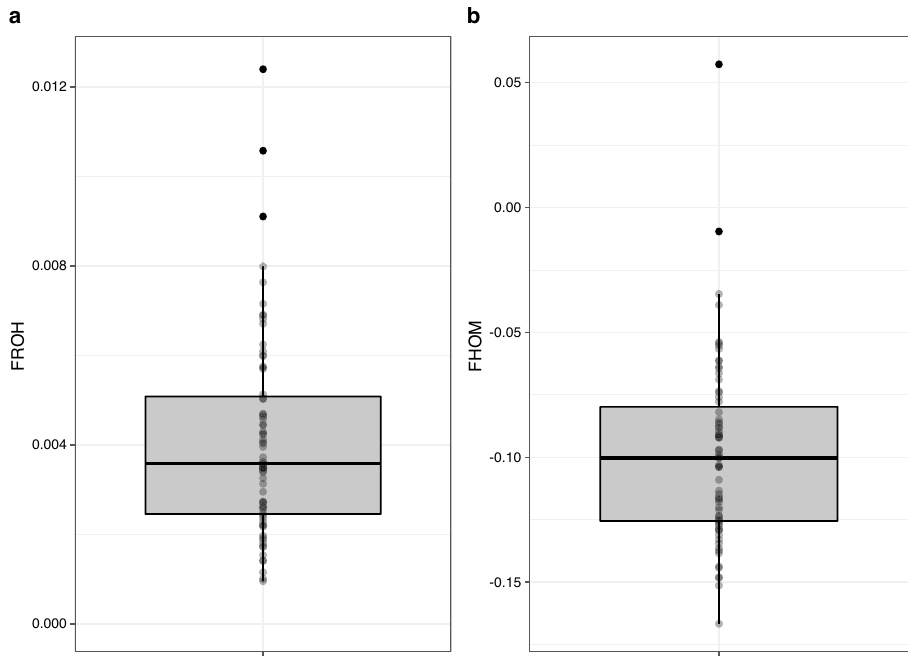
Figure 6. The distribution of F estimated from ( a ) runs of homozygosity (ROH) detection (F ROH ) and ( b ) ROH coefficients (F HOM ), across 71 African wild dogs ( Lycaon pictus ) from Kruger National Park (KNP), South